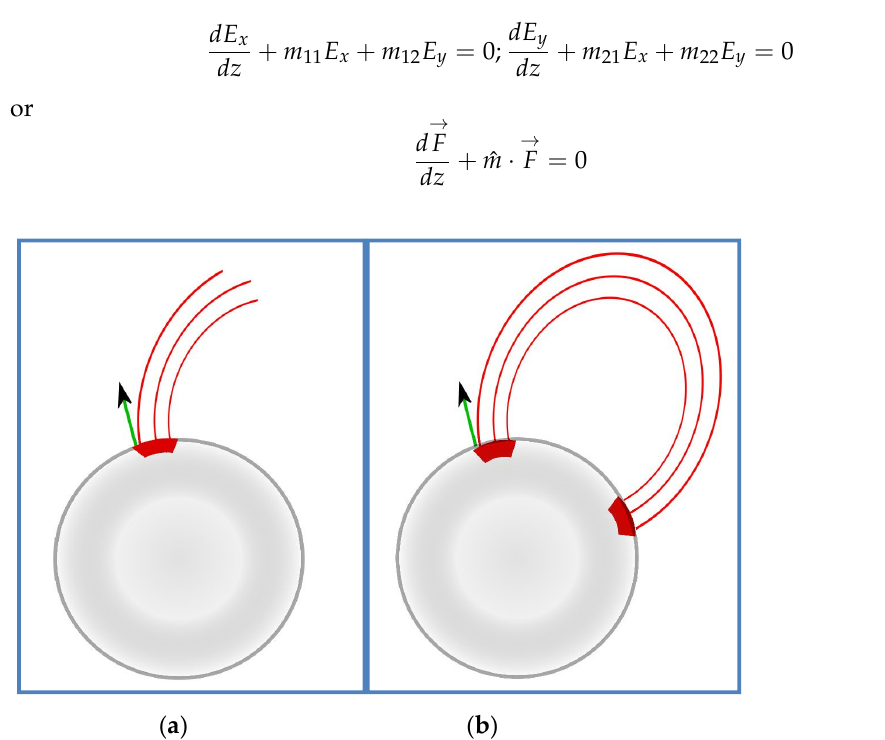
Figure 2. Geometry of the problem. Part ( a ) concerns geomagnetic field lines that go to the magnetosphere and do not return to the Earth (open field lines), ( b ) the return of geomagnetic field lines to the Earth’s surface (closed field lines).